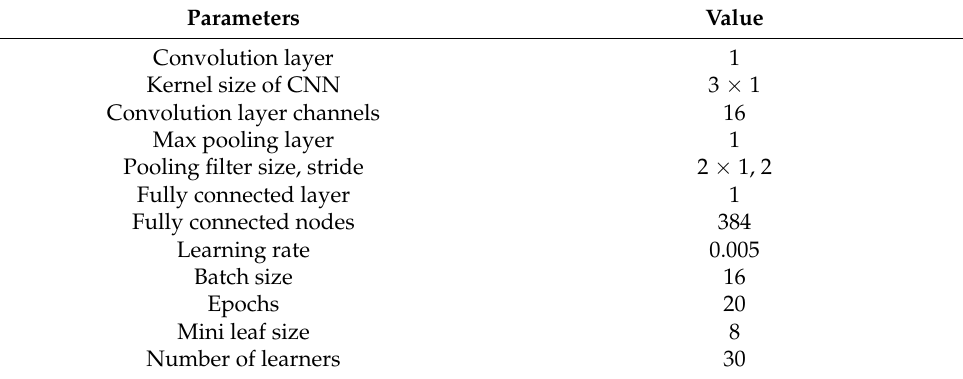
Figure 3. Architecture of the proposed CNN–RF method. Table 2. Hyperparameters of the proposed CNN–RF model.